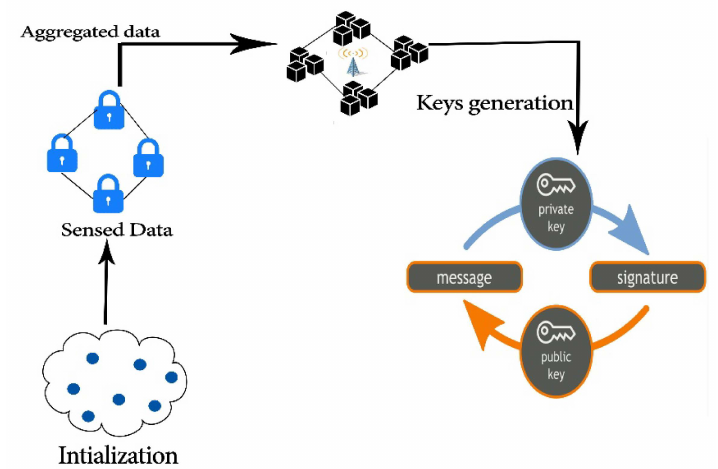
Figure 1. Flow diagram of the security